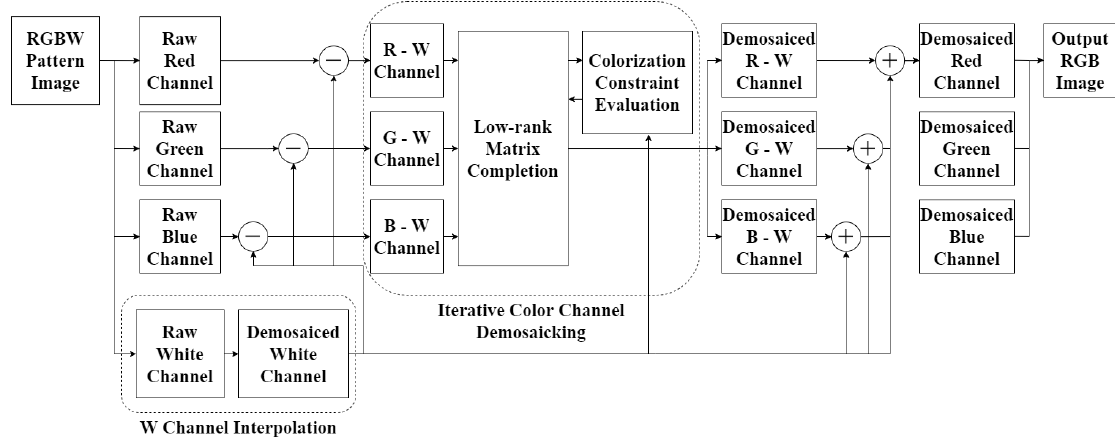
Figure 3. Diagram of the proposed